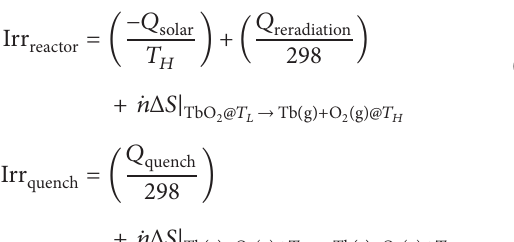
and 𝜂 as a function of 𝑇 𝐻 cycle solar-to-fuel